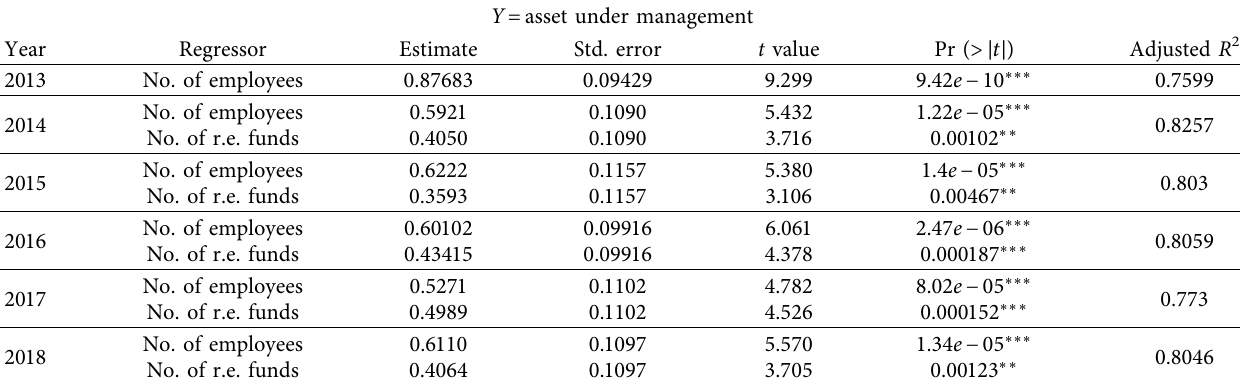
Table 7: Coefficients resulting from the first regression.